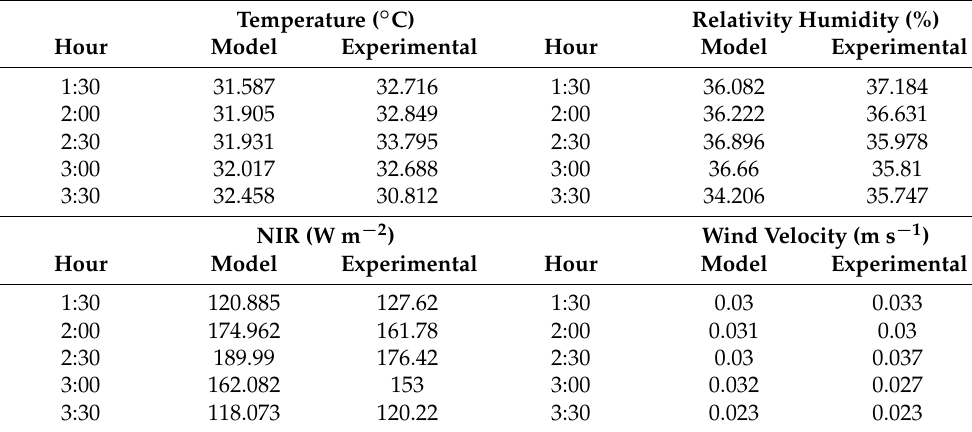
Table 4. Mean measurements of temperature, relative humidity, NIR, and wind speed data in the models were evaluated after midday.